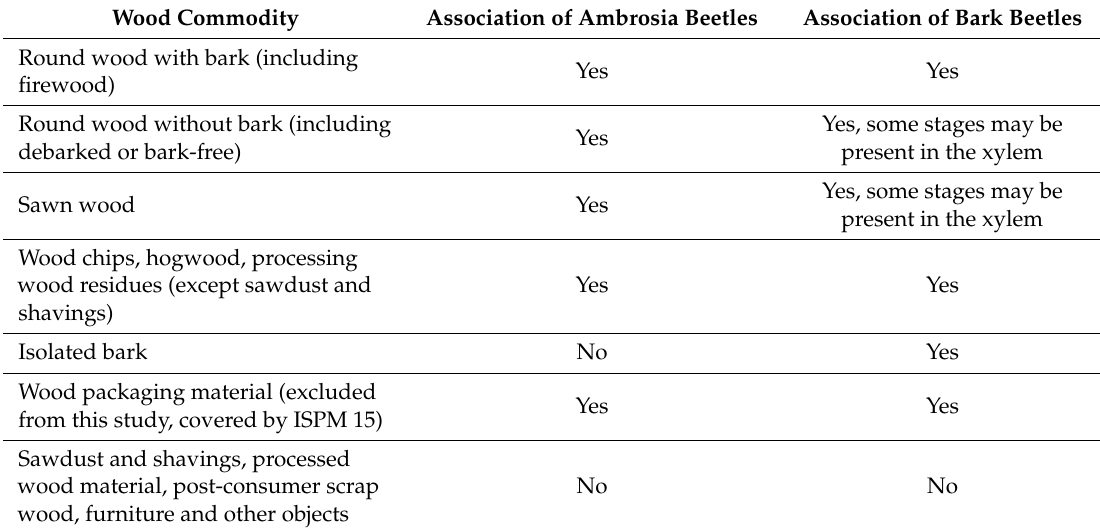
Table 3. Association of bark and ambrosia beetles with wood commodities. Wood Commodity Association of Ambrosia Beetles Association of Bark